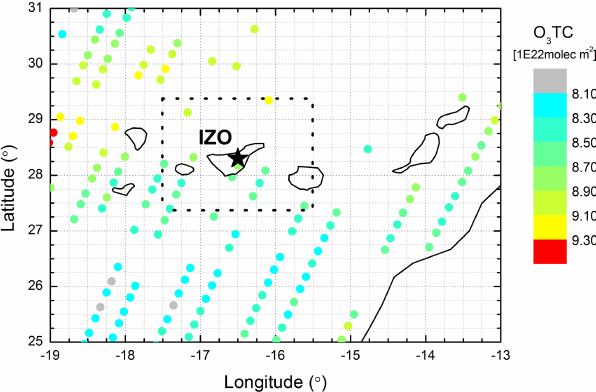
Figure 1. Site map indicating the location of the Izaña Atmospheric Observatory (IZO, marked by a black star) in the Canary Islands and the collocation box used for comparison (dashed lines), i.e. ± 1 ◦ latitude/longitude centred at IZO location. The grid lines divide the area into boxes of 0.25 ◦ . Coloured filled circles correspond to IASI- A ozone total column observations on 31 January